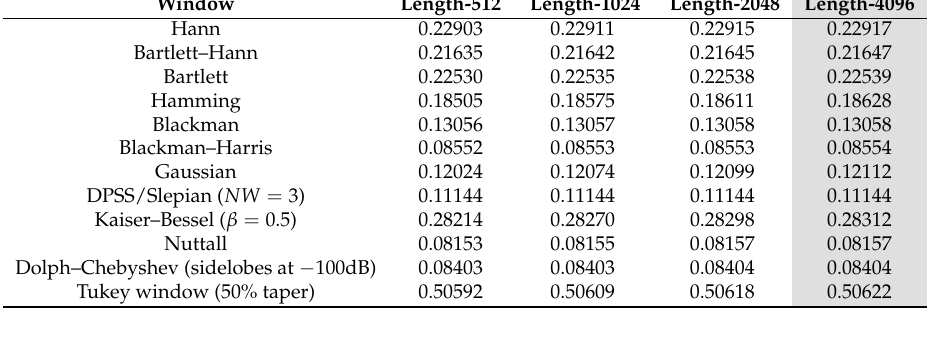
Table 2. The values of p that minimize E [ | e K ( K ) | ] for the twelve length-4096 windows (highlighted column) used for tests in Figure 10, as well as length-512, -1024, and -2048 versions of the same windows. p is rounded to five decimal points.